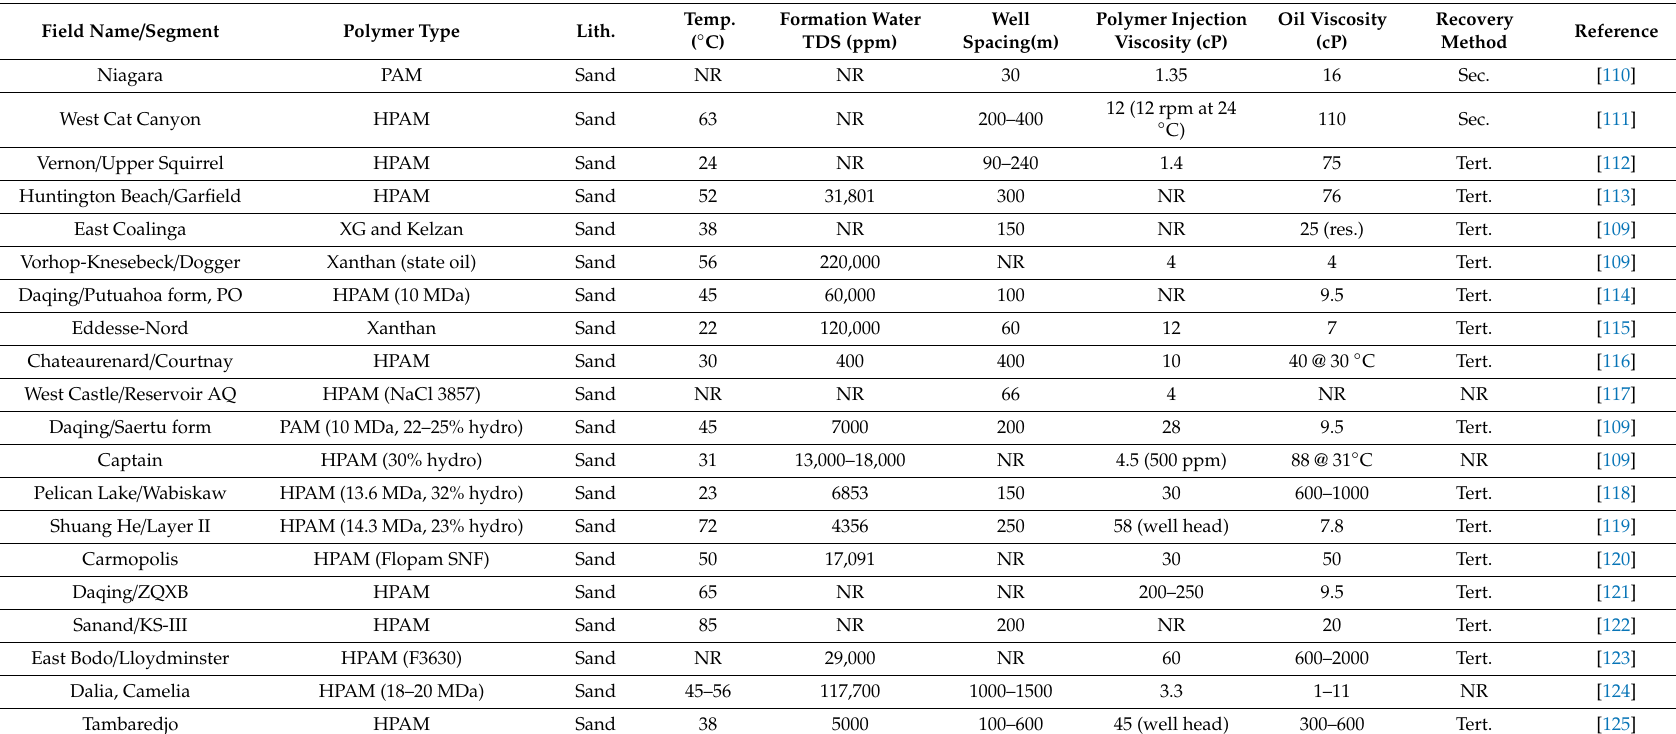
Table 6. Key information of some of the field projects reported in the